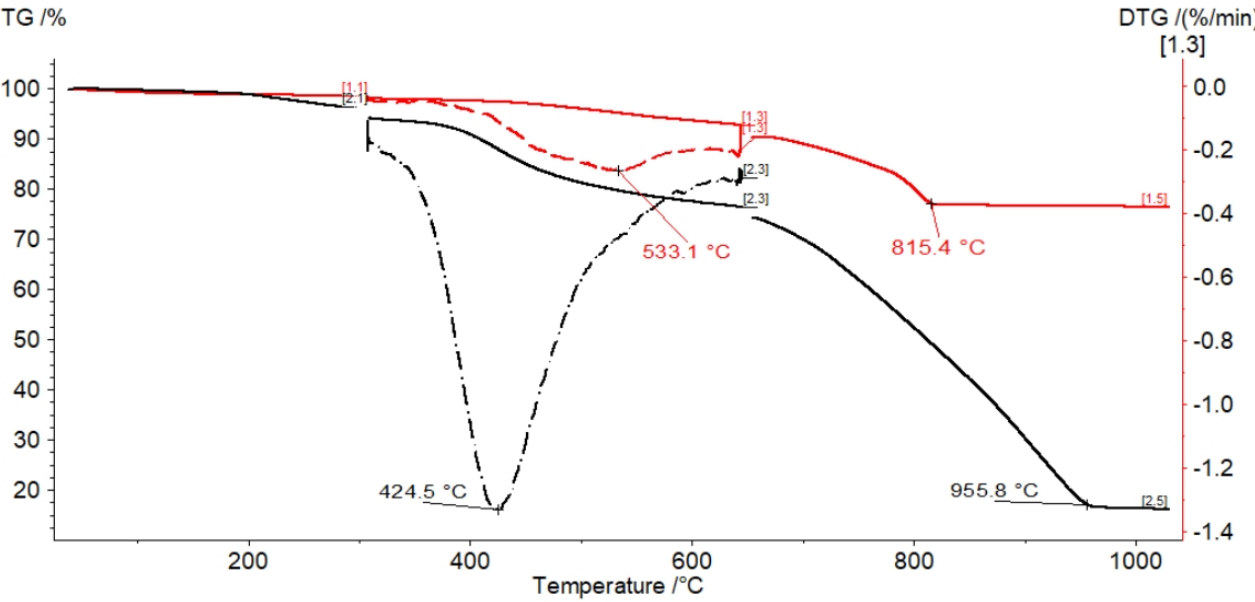
Figure 6. Results of thermogravimetric analysis obtained for the rock sample no. 7 (red curves) and the kerogen separated from it (7K; black curves). TG—solid lines; DTG—dashed lines.